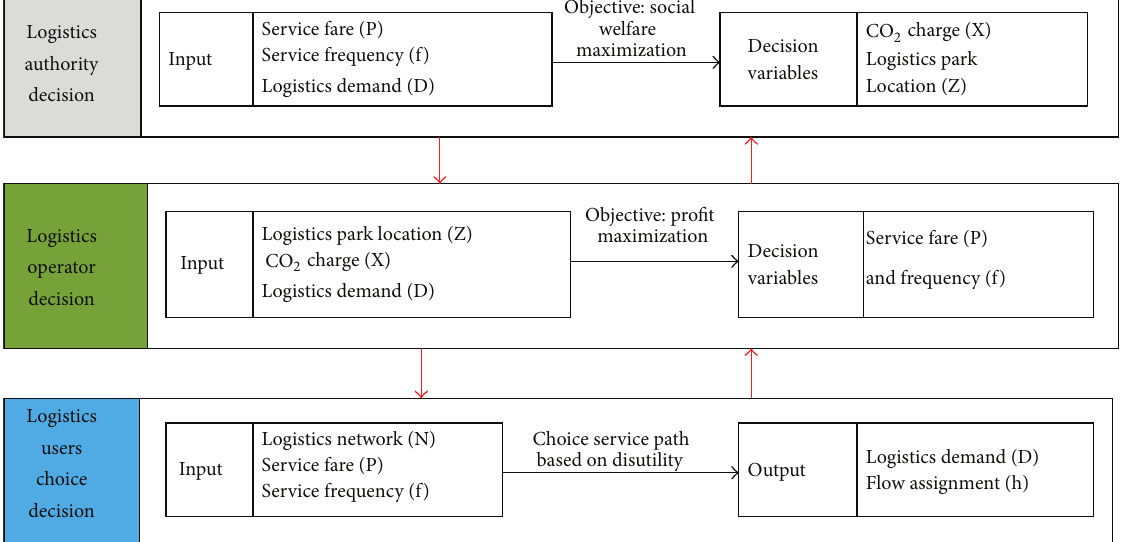
Figure 4: Decision relationship analyses on regional logistics